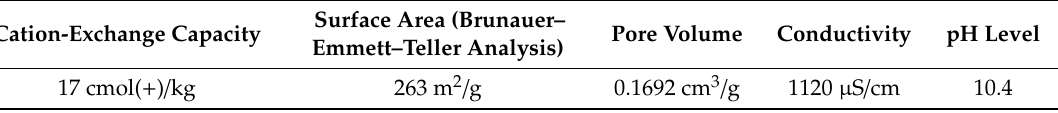
Table 3. Characteristics of the charcoal added to the experimental diets of the turkey toms in Experiments 1 and 2, analysed by the Fraunhofer Institute for Environmental, Safety and Energy Technology UMSICHT (Sulzbach-Rosenberg,